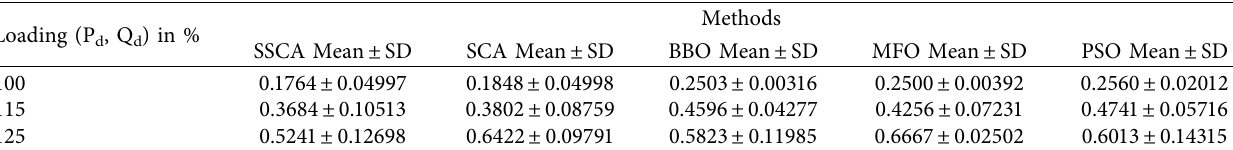
Table 5: Statistical analysis of APL for IEEE 57 bus